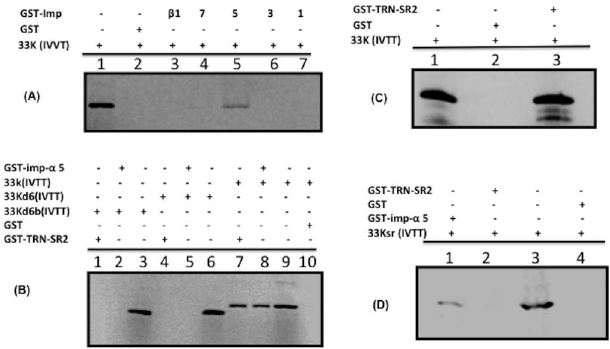
Figure 5. In-vitro interaction of 33K with transport receptors. ( A ) Purified GST fusions of importin - a 1 (lane 7), - a 3 (lane 6), - a 5 (lane 5), - a 7 (lane 4) or importin - b 1 (lane 2) along with GST alone were incubated with in -vitro transcribed and translated, [ 35 S]-labeled 33K. Input [ 35 S]-labeled 33K (lane 1). ( B ) Purified GST fusions of importin- a 5 (lanes 2,5,8) or TRN-SR2 (lanes 1,4,7) along with GST alone (lane 10) were incubated with in-vitro transcribed and translated [ 35 S]-labeled 33K (lanes 8,10), 33Kd6 (lanes 4,5) or 33Kd6b proteins (lanes 1,2). Input [ 35 S]-labeled 33K (lane 9), [ 35 S]-labeled 33Kd6 (lane 6), [ 35 S]-labeled 33Kd6b (lane 3) ( C ) Purified GST-TRN-SR2 fusion protein (lanes 2,3) or GST alone (lane 2) were incubated with in-vitro transcribed and translated [ 35 S]-labeled 33K (lane 2,3). Input [ 35 S]-labeled 33K (lane 1). ( D ) Purified GST- importin- a 5 fusion protein (lane 1), GST-TRN- SR2 fusion protein (lane 2) or GST alone (lane 4) were incubated with in-vitro transcribed and translated [ 35 S]-labeled 33Ksr protein (lanes1, 3). Input [ 35 S]-labeled 33K (lane 3). Samples from (A), (B), (C) and (D) were pulled down with glutathione Sepharose beads, separated by 10% SDS-PAGE and visualized using a phosphor screen. 10% of the input [ 35 S]-protein was run as a control.